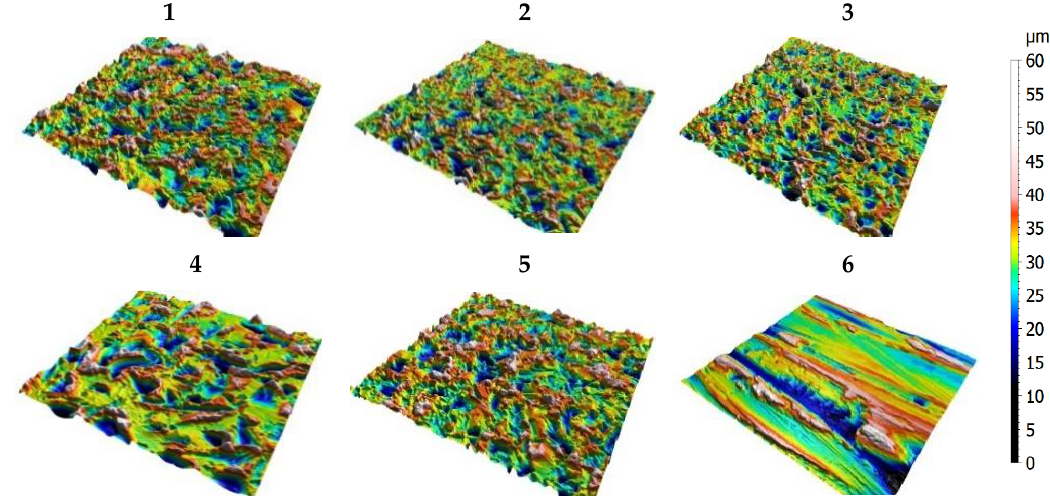
Figure 4. The five topographies ( 1 – 5 ) obtained with different mechanical treatments applied on initial surface ( 6 ).